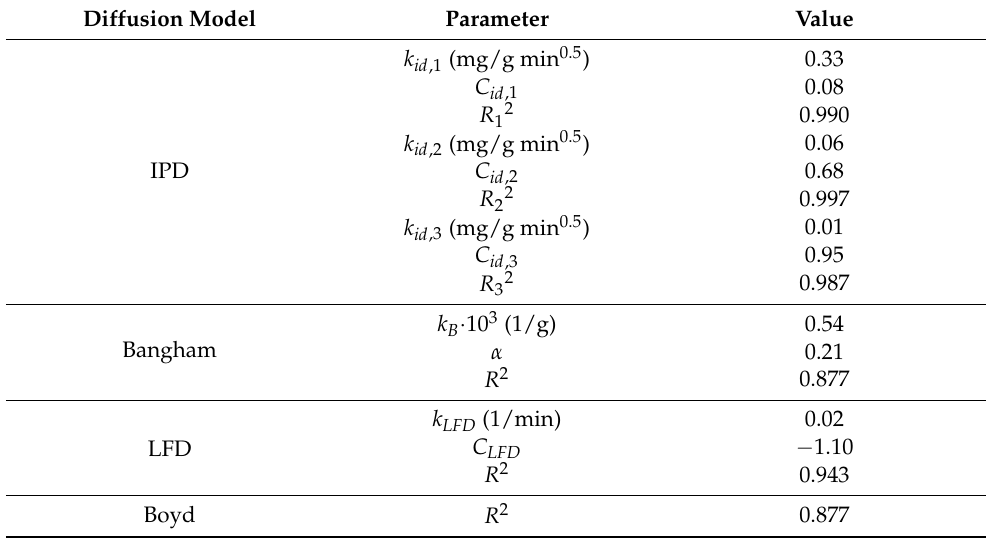
Table 2. Parameters of diffusion models for chromium sorption onto Fe 3 O 4